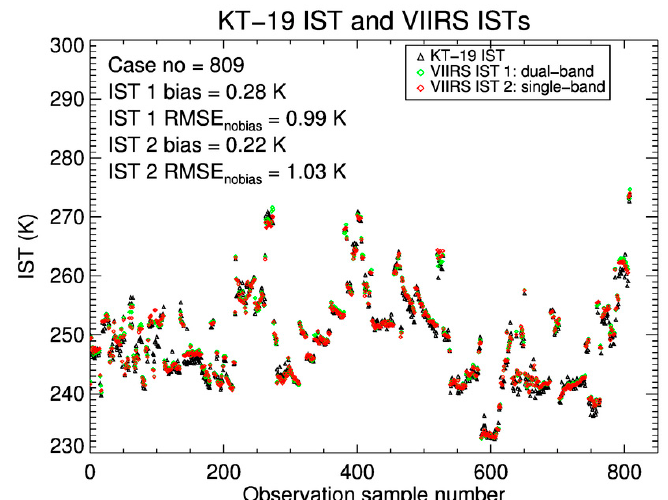
Figure 8. Comparison of IceBridge KT-19 ice surface temperature (IST) and VIIRS derived IST from various scenes using dual-band and single-band algorithms from the S-NPP moderate resolution bands.